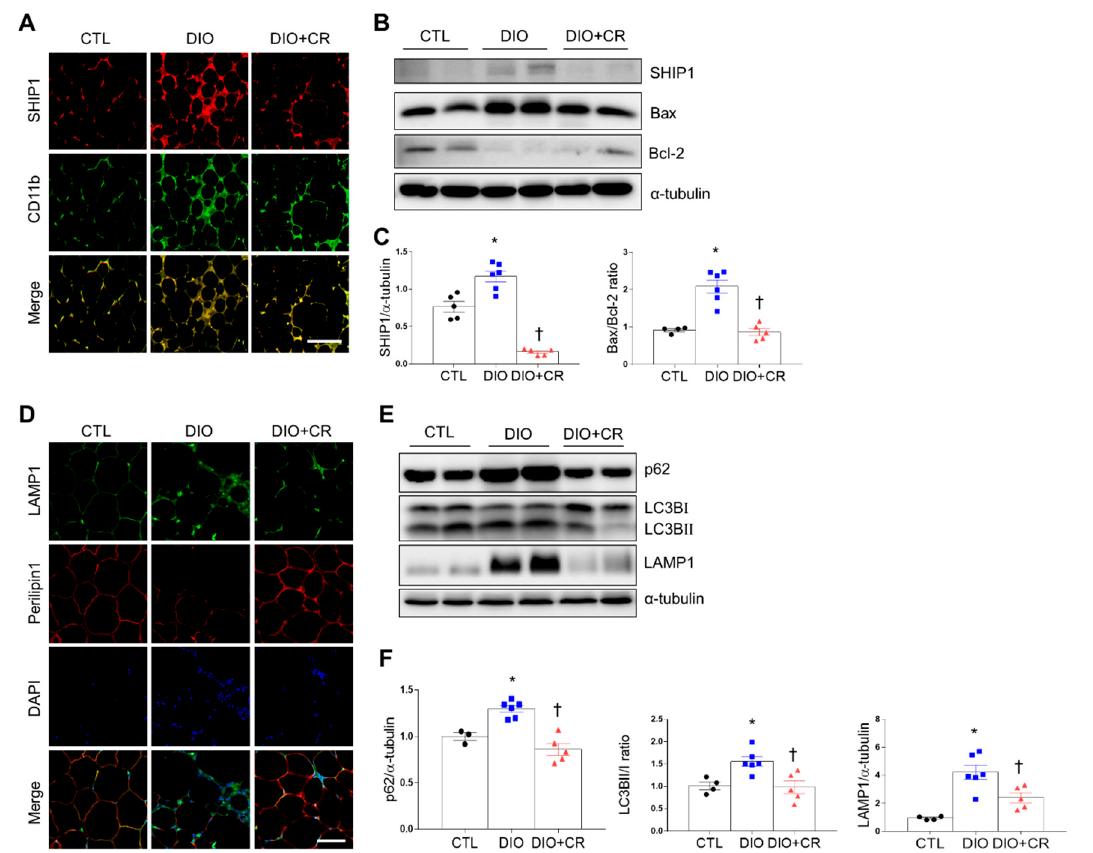
Figure 5. Effects of caloric restriction (CR) on SHIP1 expression in the adipose tissue of diet-induced obesity (DIO) mice. ( A ) Representative immunofluorescent images (200 × ) of SHIP1 (red) and CD11b (green) in the adipose tissue of CTL mice relative to DIO mice or DIO + CR mice. ( B ) Western blot analysis of SHIP1, Bax, and Bcl-2 protein expression, using α -tubulin as a reference protein. ( C ) Quantitative Western blot analysis of SHIP1 and Bax / Bcl-2 ratio in adipose tissue. ( D ) Representative immunofluorescent images (200 × ) of LAMP1 (green) and perilipin 1 (red) in the adipose tissue of CTL mice relative to DIO mice or DIO + CR mice. ( E ) Western blot analysis of p62, LC3B, and LAMP1 protein expression, using α -tubulin as a reference protein. ( F ) Quantitative Western blot analysis of p62, LC3BII / I ratio, and LAMP1 in adipose tissue. Data are presented as the means ± SEM; * p < 0.05 versus CTL mice; † p < 0.05 versus DIO mice. Scale bar = 50 µ m. CTL (black circle), DIO (blue square), DIO + CR (red triangle).